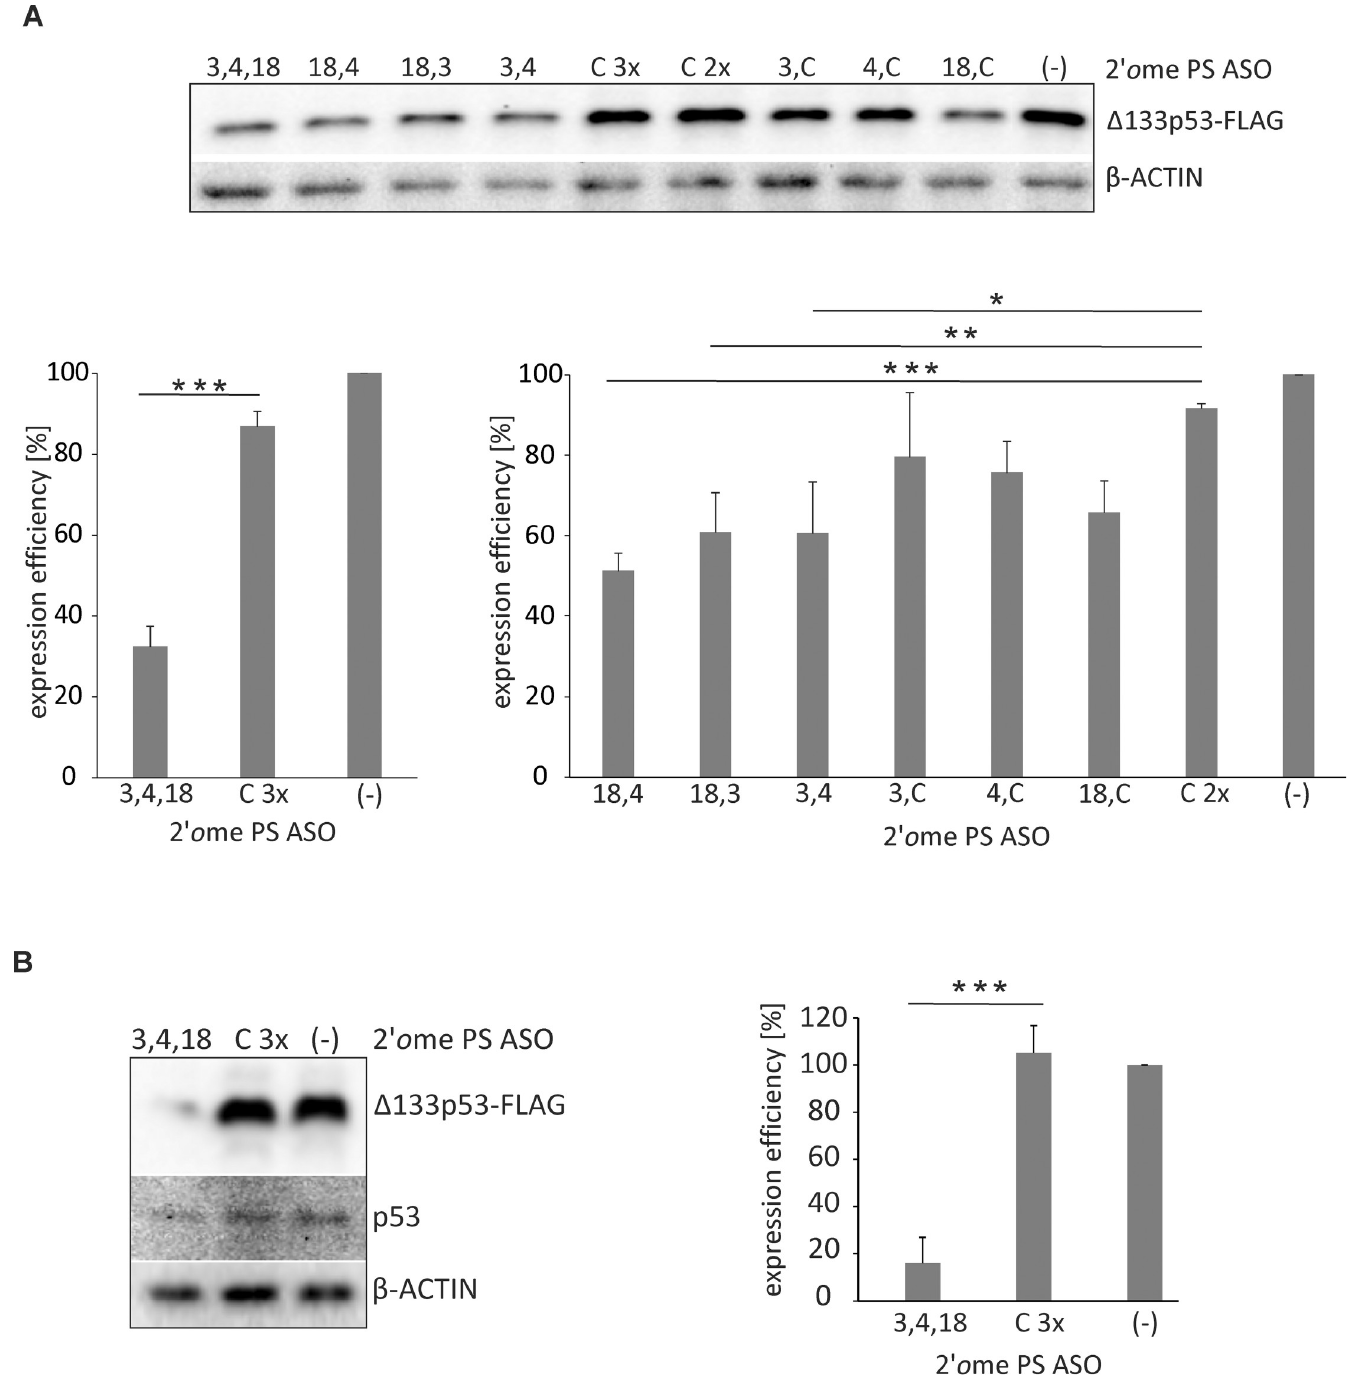
Fig 7. Western blot analysis of Δ 133p53-FLAG expression in H1299 and MCF-7 cells transfected with 2 0 O Me PS RNA antisense oligonucleotide mixes. The blots present Δ 133p53-FLAG isoform levels in H1299 (A) and in MCF-7 (B) cells in the presence of the mixes of oligomers No. 3, 4, 18 and control C oligomer. The cells were transfected with Δ 133p53 expression vector with FLAG-tag and subsequently oligomers No. 3, 4, 18 and oligomer C were transfected in mixes, each at a concentration of 0.15 μ M and the final concentration of oligomer mixes in the reaction did not exceed 0.45 μ M. Mixes used in the experiment are listed on the graphs. Control oligomer C was used at a concentration of 0.30 μ M and 0.45 μ M; lines C2x and C3x, respectively. The experiments were performed in at least three independent repetitions and the values were normalized to those without oligonucleotides added (-). The β -actin level was used as a loading control. The p value was calculated by the Student’s t-test and significant comparisons are marked with asterisks: ( p < 0.05) � , ( p < 0.01) �� , ( p < 0.001) ��� .